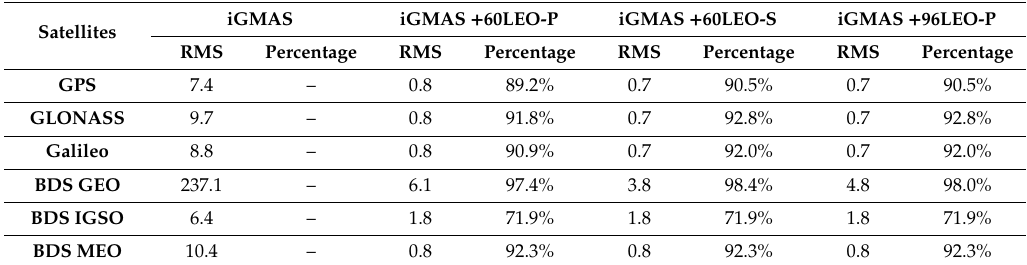
to the result of POD using ground iGMAS data (Unit: